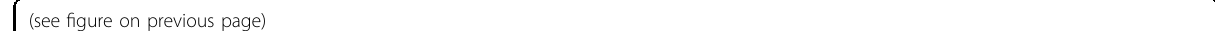
Fig. 6 Metformin inhibited the expression of METTL3 in SUM-1315 and MCF-7 cells by targeting miR-483-3p. A , B Metformin upregulated miR-483-3p markedly in both SUM-1315 and MCF-7 cells and miR-596-5p moderately in only SUM-1315 cells. The relative expression of miRNA was calculated by the 2 − ΔΔ Ct method and normalized based on U6. The average miRNA level in the metformin untreated group was set as 1. ** p < 0.01, *** p < 0.001 vs. metformin untreated group. C – G Inhibitor of miR-483-3p could counteract metformin-induced METTL3 downregulation and cell growth inhibition in SUM-1315 and MCF-7 cells. The relative expression of miRNA was calculated by the 2 − ΔΔ Ct method and normalized based on U6. The average miRNA level in the metformin untreated group was set as 1. * p < 0.05, ** p < 0.01, *** p < 0.001 vs. metformin-treated group. H , I MiR-483- 3p mimics decreased the METTL3 expression both in mRNA and protein levels. The relative RNA level was calculated by the 2 − ΔΔ Ct method and normalized based on β -actin. The average mRNA level of p21 in the NC group was set as 1. *** p < 0.001 vs. NC group. J , K MiR-483-3p mimic only inhibited the luciferase activity of the METTL3 wild-type reporter (not Mutant-type) in SUM-1315 and MCF-7 cells. ** p < 0.01, *** p < 0.001 vs. nc-mimic group. L – O CCK-8 and colony formation assays showed that miR-483-3p mimic could inhibit the growth of SUM-1315 and MCF-7 cells and overexpression of METTL3 rescued the inhibitory effect of miR-483-3p. *** p < 0.001 vs. NC group, # p < 0.05, ## p < 0.01, ### p < 0.001 vs. mimic group. Met, metformin; Con, control; ns, not signi fi cant. Data represented the mean ±